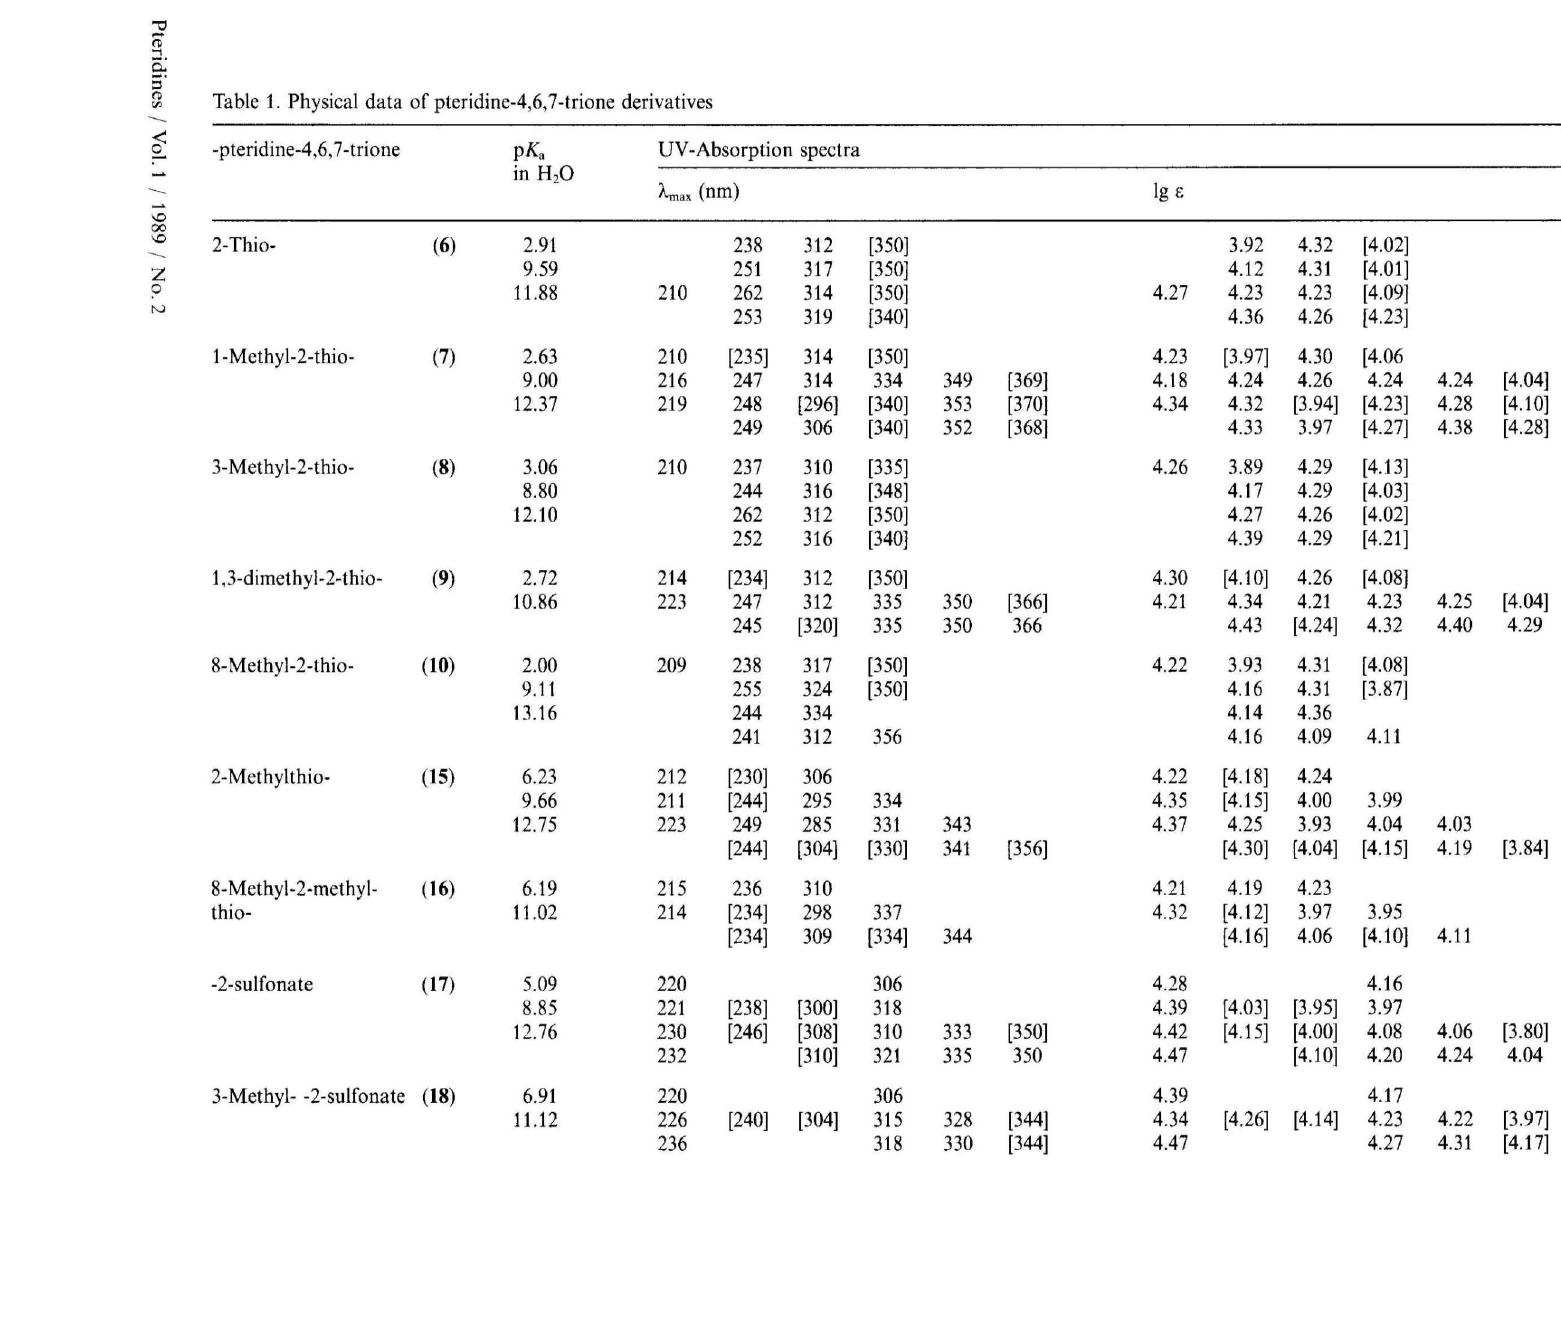
Table 1. Physical data of pteridine-4,6,7-trione derivatives